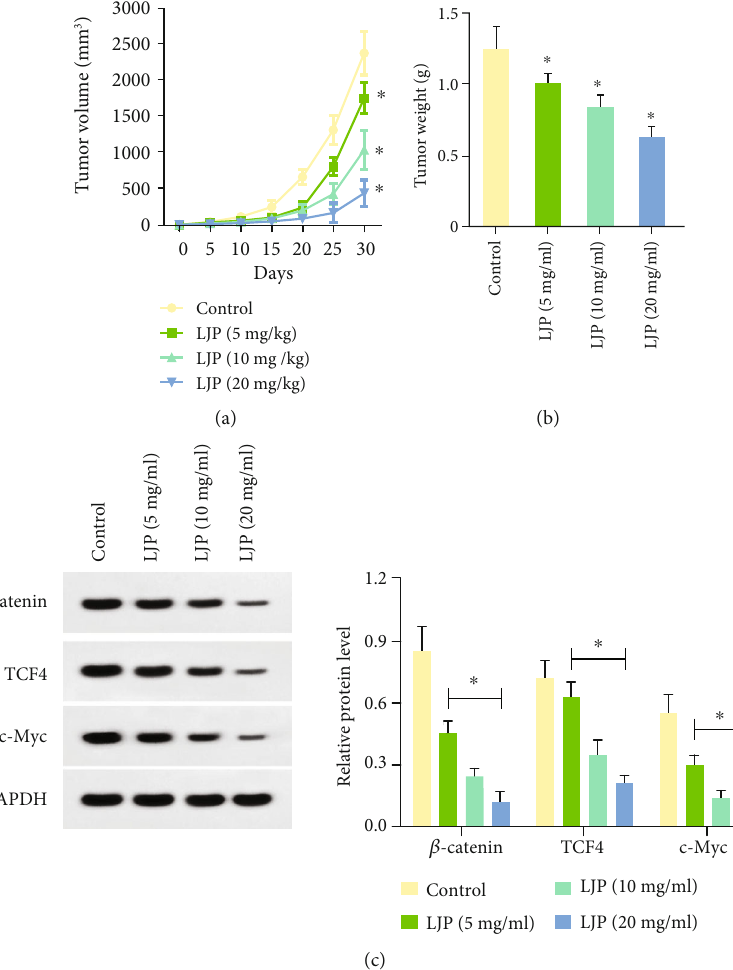
Figure 8: Growth and expression of signal pathway protein in transplanted tumor. Mice were randomly divided into 4 groups: control group, LJP (5 mg/kg), LJP (10 mg/kg), and LJP (20 mg/kg) group. Mice were given intraperitoneal injection once a day for a week. Tumor volumes (a) were measured every 5 days, and the mice were sacri fi ced at the 30 th day. Tumor weights (b) and expression of signal pathway proteins (c) in tumors were detected by Western blot. ∗ P < 0 : 05 versus control